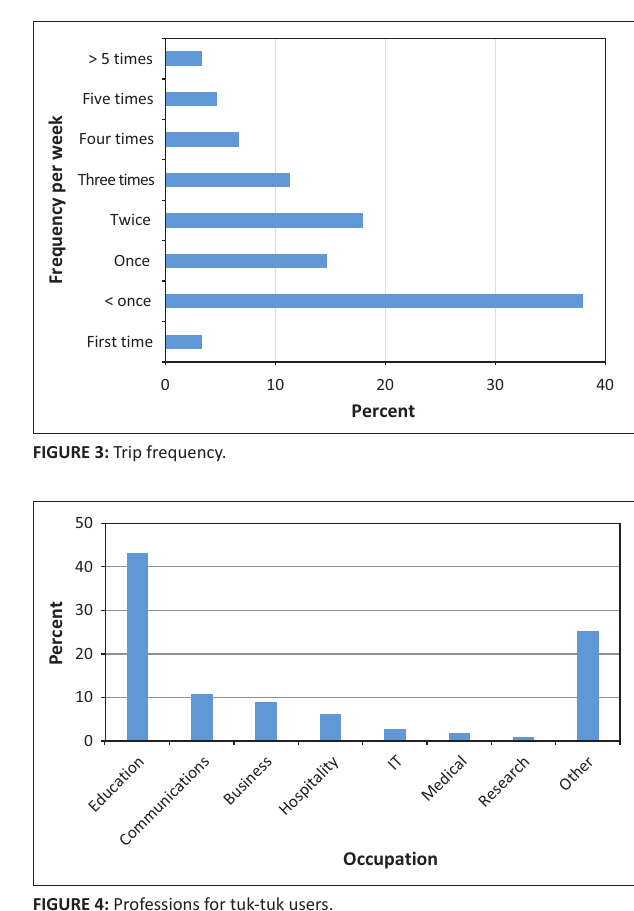
FIGURE 4: Professions for tuk-tuk